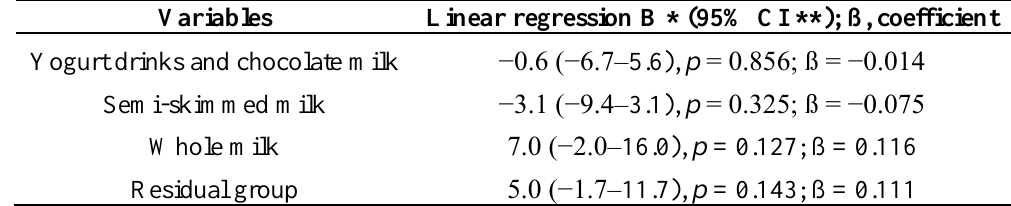
Table 4. Results linear regression of different types of milk and serum 25(OH)D 3